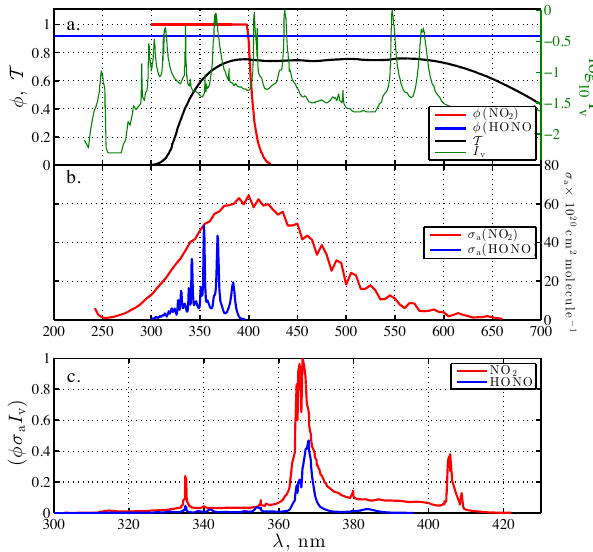
Fig. 2. The potential interference of HONO in the detection of NO 2 was estimated using (a) the scaled intensity I v of the photolytic con- verter (200-W high pressure arc mercury lamp, USHIO-200DP), the respective quantum yield φ , total transmittance T of the optical fil- ters, including a Pyrex window (Oriel, Part No. 60127) and a KBr filter (KG3, Oriel Part No. 51960), (b) the respective absorption cross sections σ a (Sander et al., 2006) and (c) scaled ( φσ a I v ) in or- der to calculate respective photolysis rate constants j = R φσ a I v d λ and their ratio. λ is wavelength and note different scale of x-axis in (c)